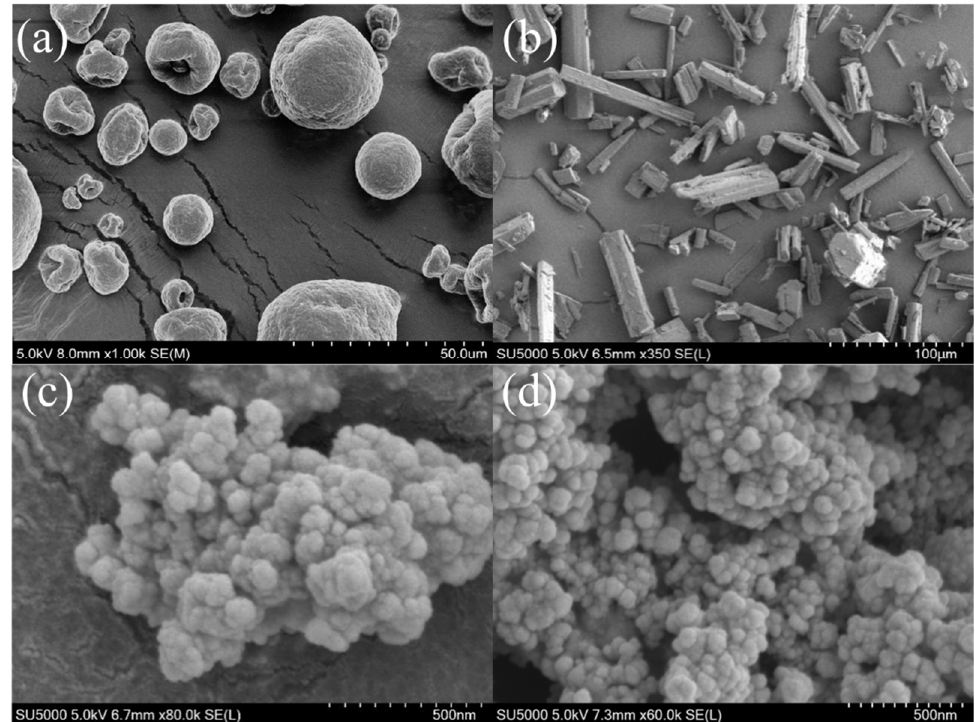
Figure 6. SEM images of BX, Res, BX/Res-g-EGDMA and 3-CBA-BX/Res-g-EGDMA. ( a ) SEM image of BX. ( a ) SEM image of BX. ( b ) SEM image of Res. ( c ) SEM image of BX/Res-g-EGDMA. ( d ) SEM image of 3-CBA-BX/Res-g-EGDMA.